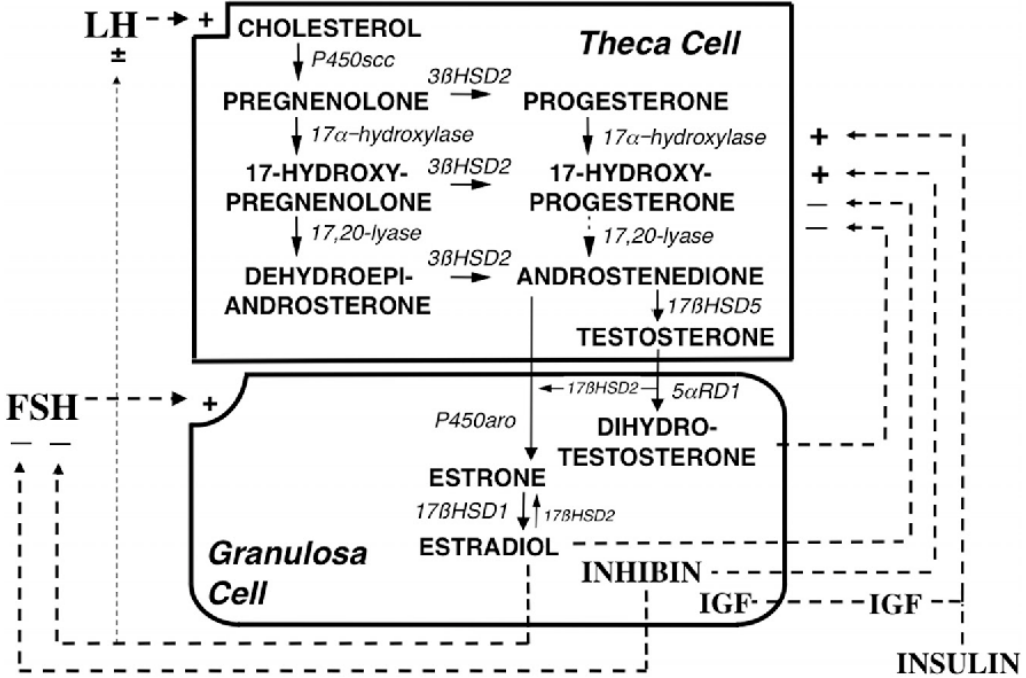
Figure 2. Depiction of the organization and regulation of the major steroid biosynthetic pathways in the small antral follicle of the ovary according to the 2-gonadotropin, 2-cell model of ovarian steroidogenesis, taken and captioned from [42] with permission of the Oxford University Press. LH stimulates androgen formation within theca cells via the steroidogenic pathway common to the gonads and adrenal glands. FSH regulates estradiol biosynthesis from androgen by granulosa cells. Long-loop negative feedback of estradiol on gonadotropin secretion does not readily suppress LH at physiological levels of estradiol and stimulates LH under certain circumstances. Androgen formation in response to LH appears to be modulated by intraovarian feedback to the levels of 17-hydroxylase and 17,20-lyase, both of which are activities of CYP type 17A1, which is expressed only in theca cells. The relative quantity of androstenedione formation via 17OHP (dotted arrow) in the intact follicle is probably small, as is the amount of progesterone formed from granulosa cell CYP type 11A activity in response to FSH (data not shown). Additionally, 17 HSD2 activity is minor in the ovary, and estradiol is primarily formed from androstenedione. Androgens and estradiol inhibit (minus signs), and inhibin, insulin and IGF-1 (IGF) stimulate (plus signs) 17-hydroxylase and 17,20-lyase